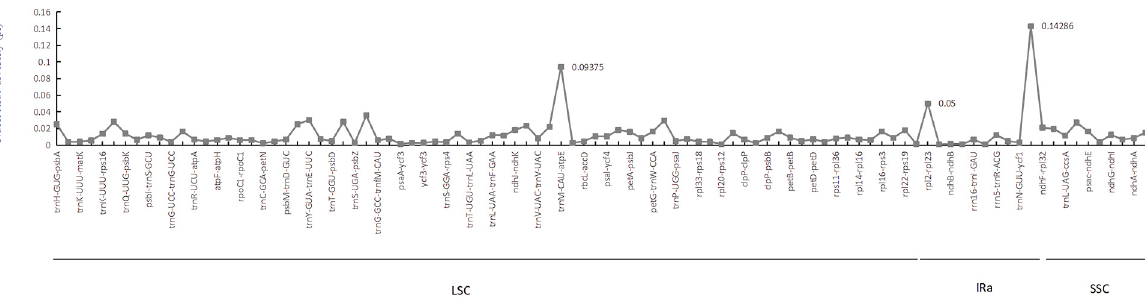
Figure 4. Nucleotide diversity ( π ) of noncoding regions between two Euonymus maackii Rupr. indi- viduals.